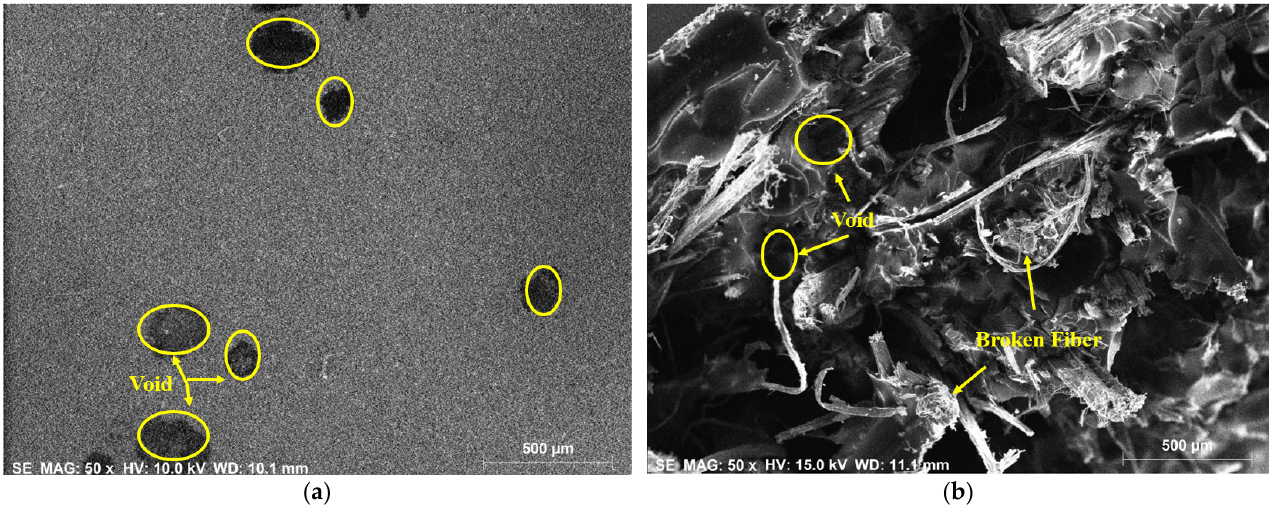
Figure 8. SEM EDX analysis on hemp fiber reinforced ecopoxy composite at surface ( a ) and fracture ( b ) positions.